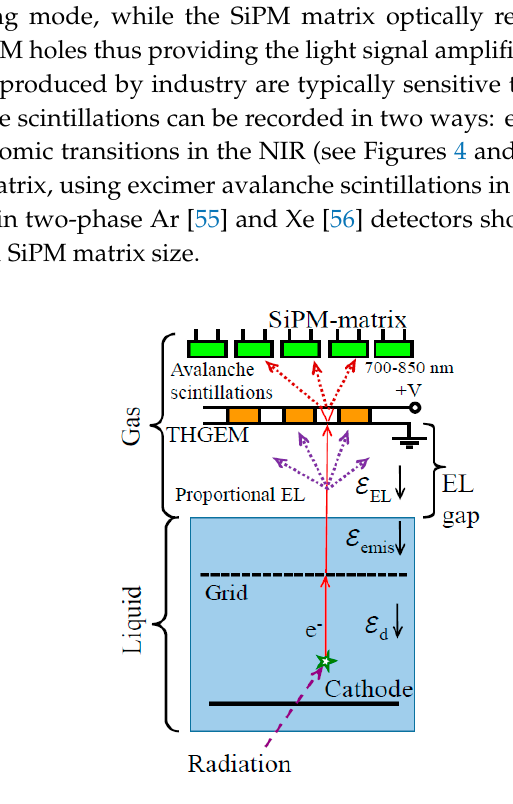
Figure 22. Concept of combined charge/light signal amplification in two-phase detector with EL gap, using avalanche scintillations and combined THGEM/SiPM-matrix multiplier.